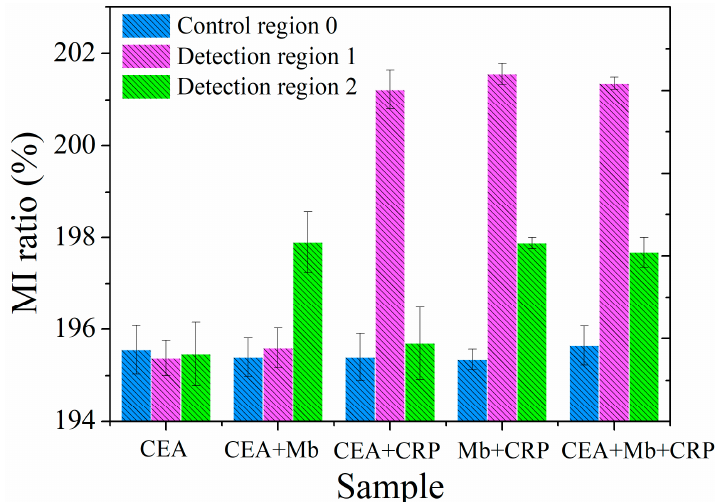
Figure 5. MI responses for the specificity test on CRP and Mb; single CEA antigen solution and four antigens mixture solution (CEA + Mb; CEA + CRP; CRP + Mb, CEA + Mb + CRP) were injected into the MR-MFD in turn.